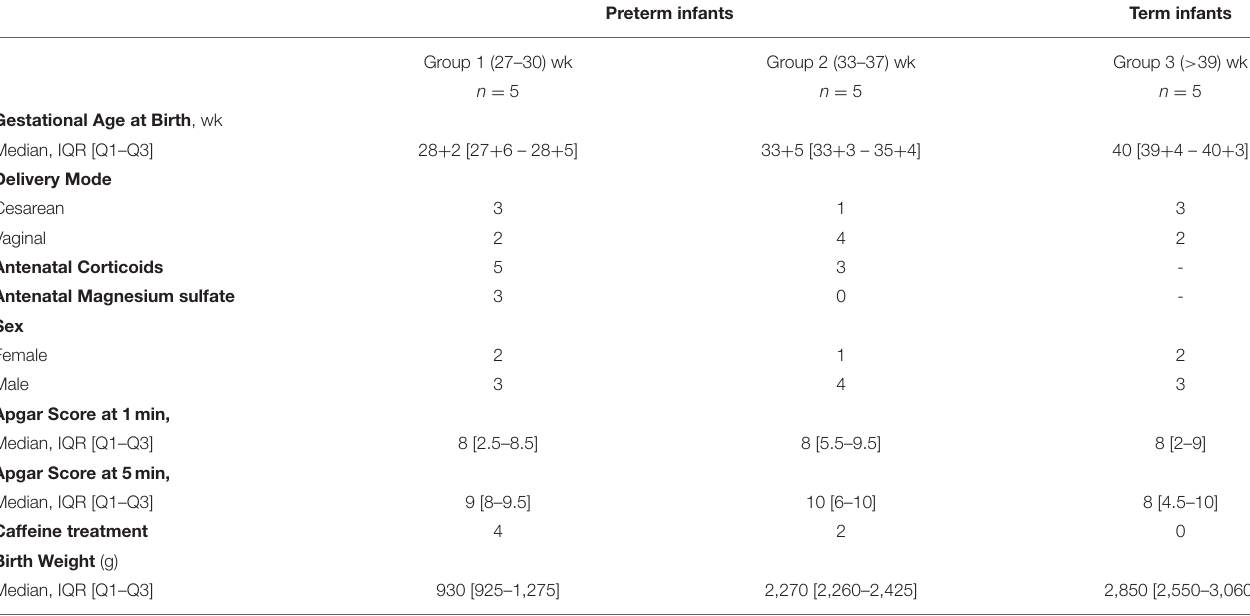
TABLE 1 | Infant and maternal characteristics.